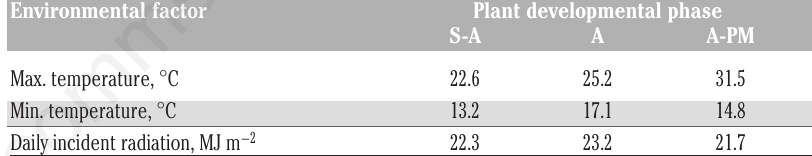
Table 1. Mean environmental data for three developmental crop phases. Crop phase A represents the 15-d interval centered on the mean date of full anthesis. Crop interval S- A is the time elapsed between sowing and 7 days before the mean date of full anthesis. A-PM is the interval between 7 days after full anthesis the date of PM.